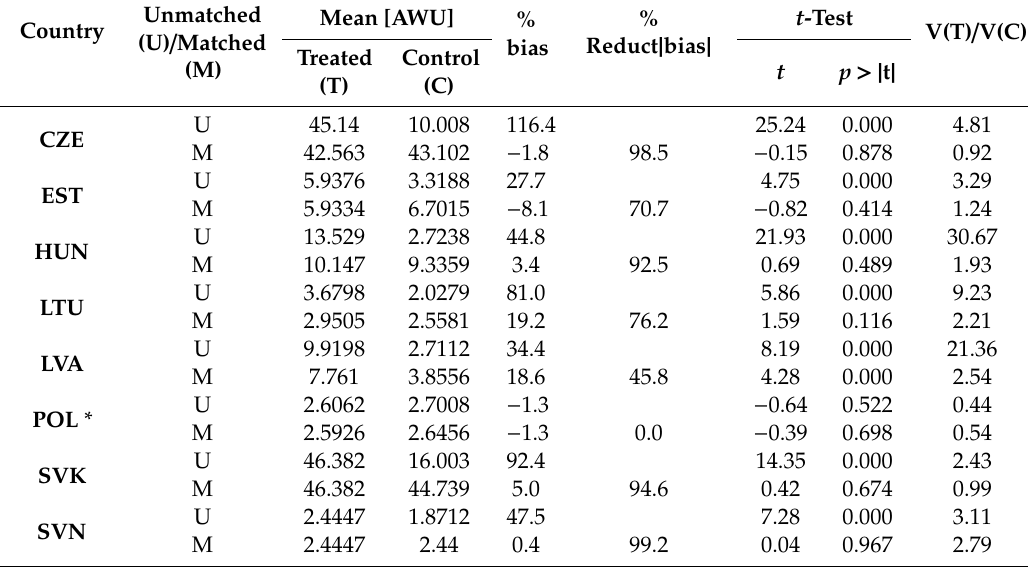
Table 2. Results of the matching procedure for the variable “labor” (in AWU, SE010).